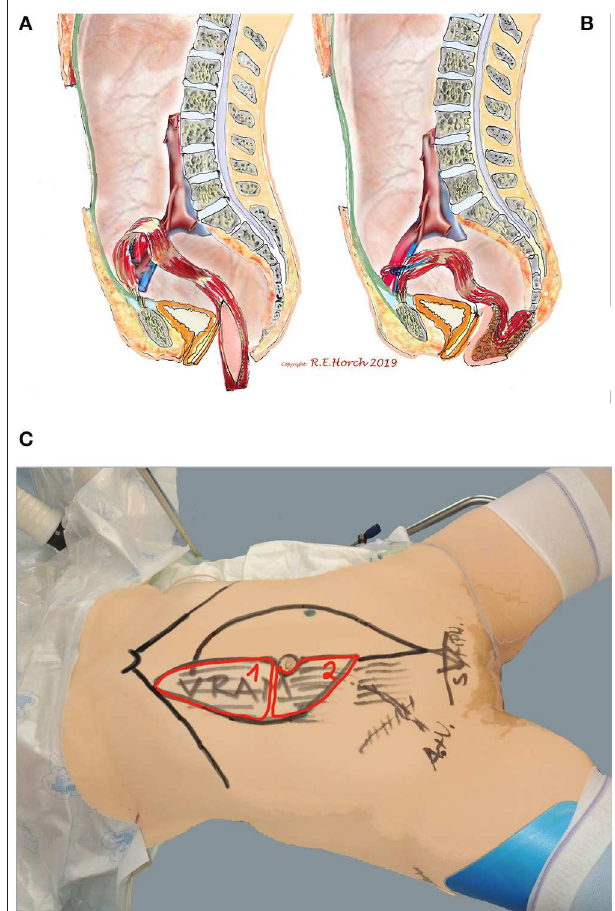
FIGURE 2 | Schematic drawing of principle of vaginal wall reconstruction with pedicled transpelvic VRAM flap. (A) VRAM flap mobilized and routed through pelvis into resectional defect. (B) VRAM flap sutured to remaining anterior vaginal wall and constructing new posterior vaginal wall. (C) Positioning of patient on operating table and schematic drawing of planned bi-parted skin island of VRAM flap to reconstruct vaginal wall and perineum/sacrum defect with the same skin